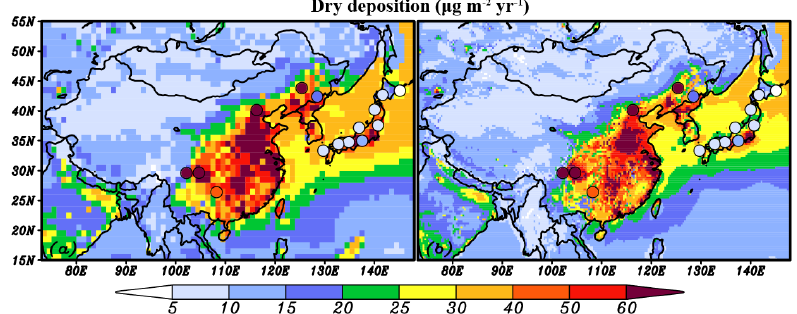
Figure 9. Simulated annual mercury dry deposition (µgm − 2 yr − 1 ) over East Asia in the global (a) and nested (b) domains in 2001. Overlaid points show observations collected from the literature. Note that observations and simulated results are not in the same year.